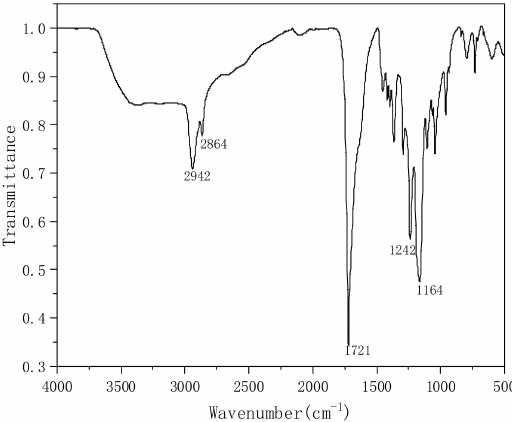
Figure 10. Infrared absorption of white turbidity after